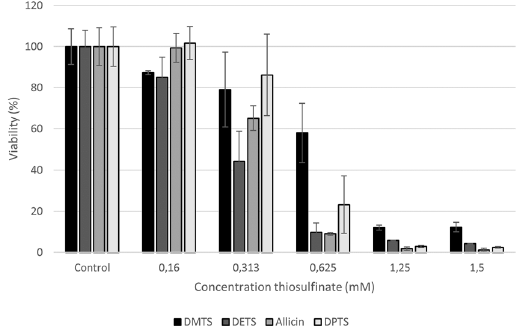
Figure 12. Dose-dependent effect of thiosulfinates on the viability of cultured human A549 cells. The experiment was repeated 4 times (n = 4–8) with similar results and a set of representative data is shown.